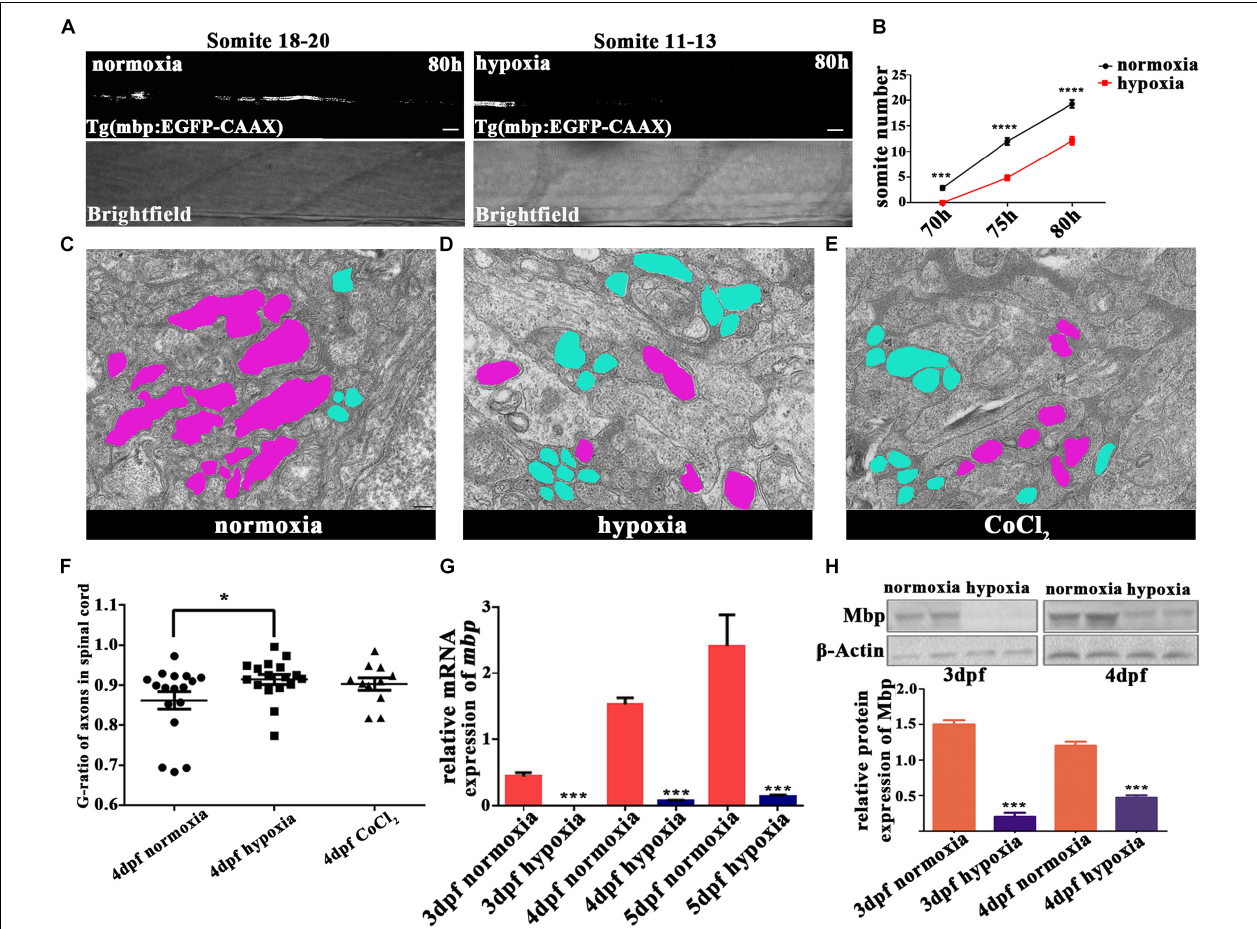
FIGURE 3 | Hypoxia delayed the onset of myelination and led to thinner myelin sheaths. (A) Myelination of the Mauthner axon, the most posterior myelin sheath in the spinal cord, at 80 hpf. Myelination can be seen between somites 18 and 20 in normoxic animals but between somites 11 and 13 in hypoxic animals. Scale bars: 10 µ m. (B) The most posterior myelin sheath at 70 hpf is somite 2.875 ± 0.3981 in normoxic animals ( n = 8) and somite 0.0 ± 0.0 in hypoxic animals ( n = 8); at 75 hpf is somite 12.00 ± 0.6814 in normoxic animals ( n = 8) and somite 4.857 ± 0.5084 in hypoxic animals ( n = 7); and at 80 hpf is somite 19.27 ± 0.7519 in normoxic animals ( n = 8) and somite 12.13 ± 0.7892 in hypoxic animals ( n = 7). Two-way ANOVA, P < 0.0001. (C–E) A large number of unmyelinated axons (shaded in blue) were observed in the spinal cord axons of the hypoxic and CoCl 2 groups as compared to the myelinated axons (shaded in purple) observed in the normoxic group. Scale bars: 200 nm. (F) The hypoxic group had a higher G-ratio in the spinal cord axon than did the normoxic group, indicating delayed-onset myelination under hypoxia. One-way ANOVA, P < 0.05. (G) qRT-PCR analysis indicated that myelin basic protein ( mbp ) mRNA transcription was significantly decreased under hypoxia. (H) The expression of the Mbp protein was analyzed with western blots. The results showed that hypoxia blocked Mbp protein translation. Larvae at 3 and 4 dpf (30 per day) were pooled for western blot experiments. ∗ P < 0.05; ∗∗ P < 0.01; ∗∗∗ P < 0.001; ∗∗∗∗ P <